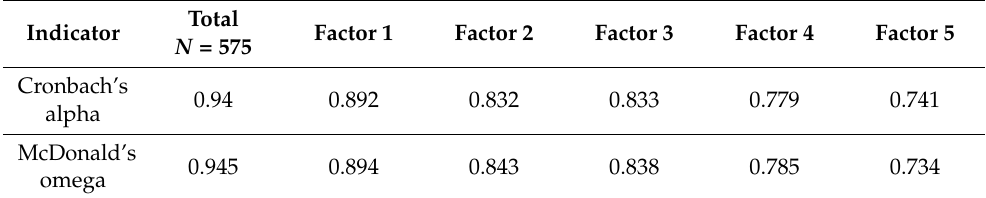
Table 4. Internal reliability (consistency) analysis for the Spanish version of the